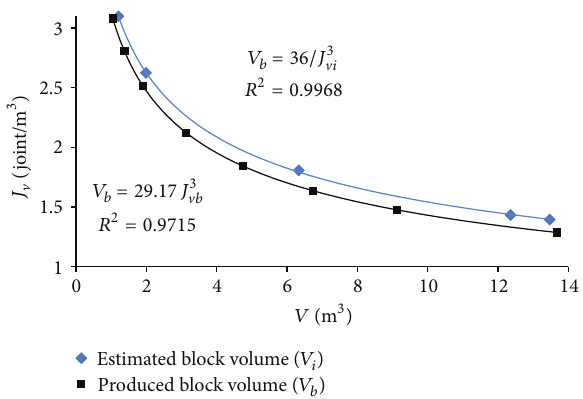
Figure 5: The relation between the volumetric joint counts, mean discontinuity spacings ( 𝐽 V 𝑖 , J V 𝑏 ), and block volumes (𝑉 𝑖 ,𝑉 𝑏 ) of the Karaburun limestone.